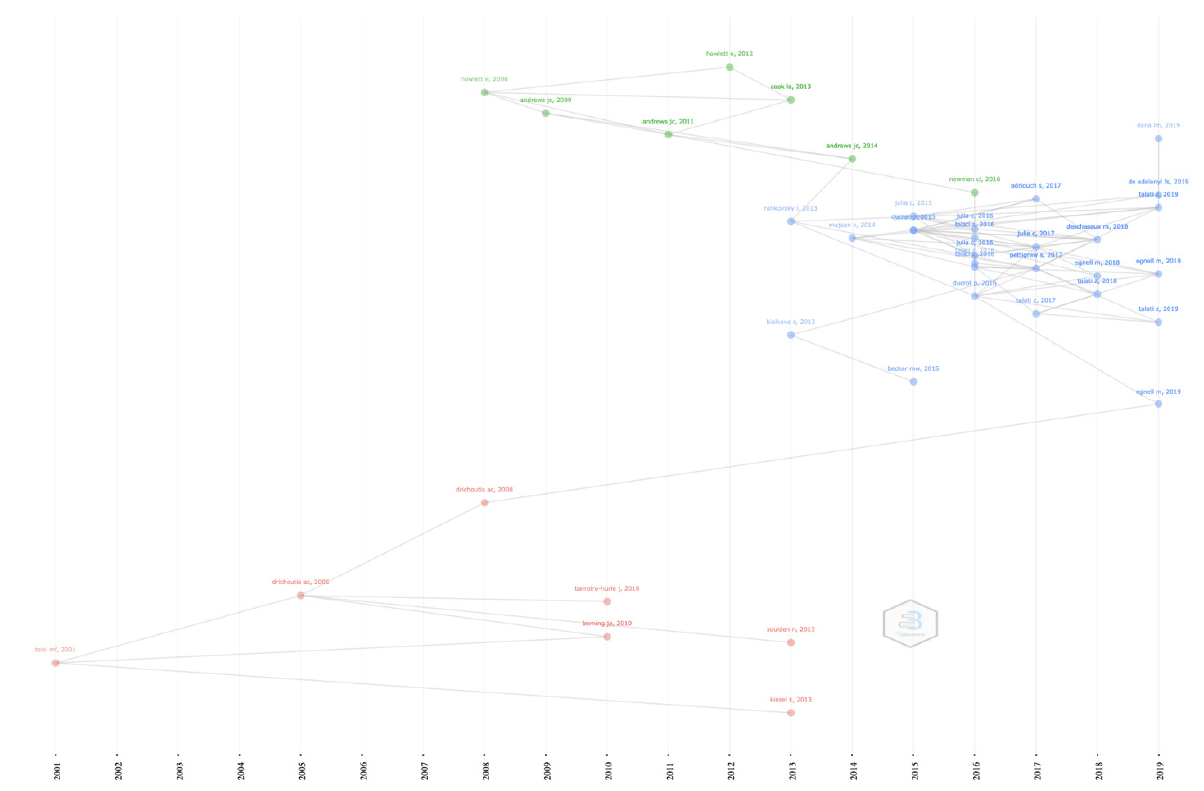
Figure 8. Co-citation evolution over time.